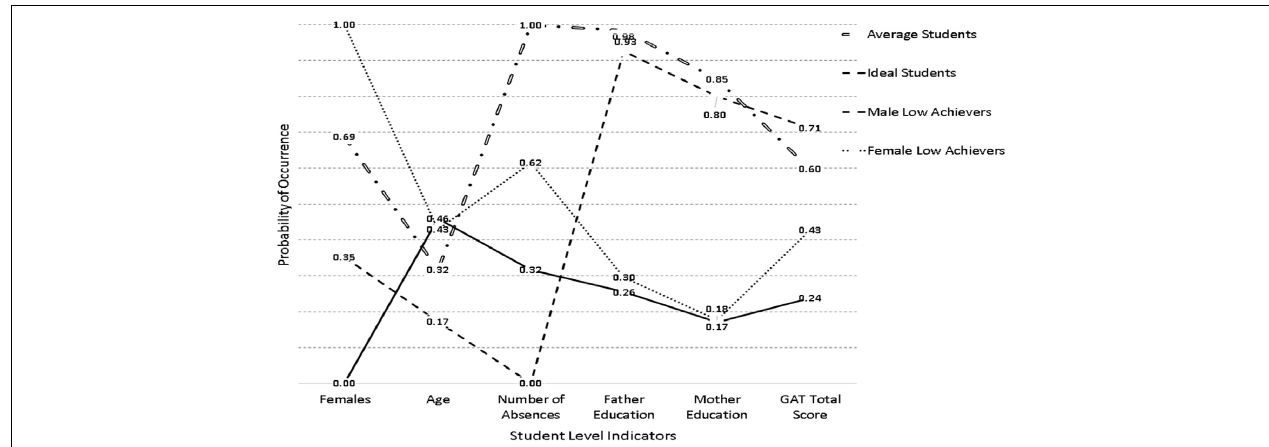
FIGURE 2 | Latent class solutions in the year 2017.